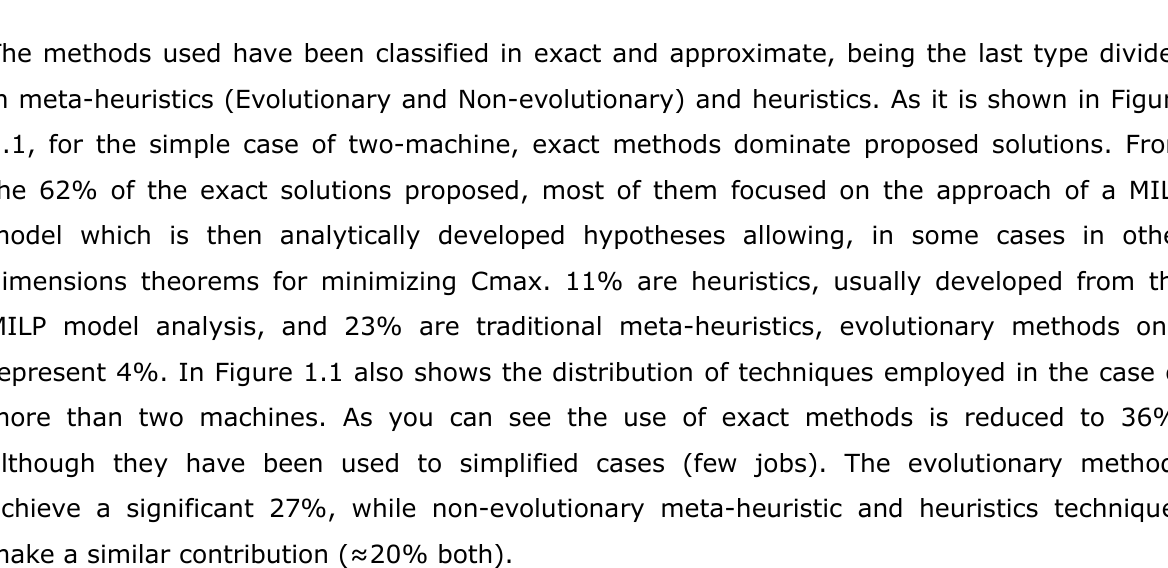
Figure 1. Methods used for two-machine and m-machine flow